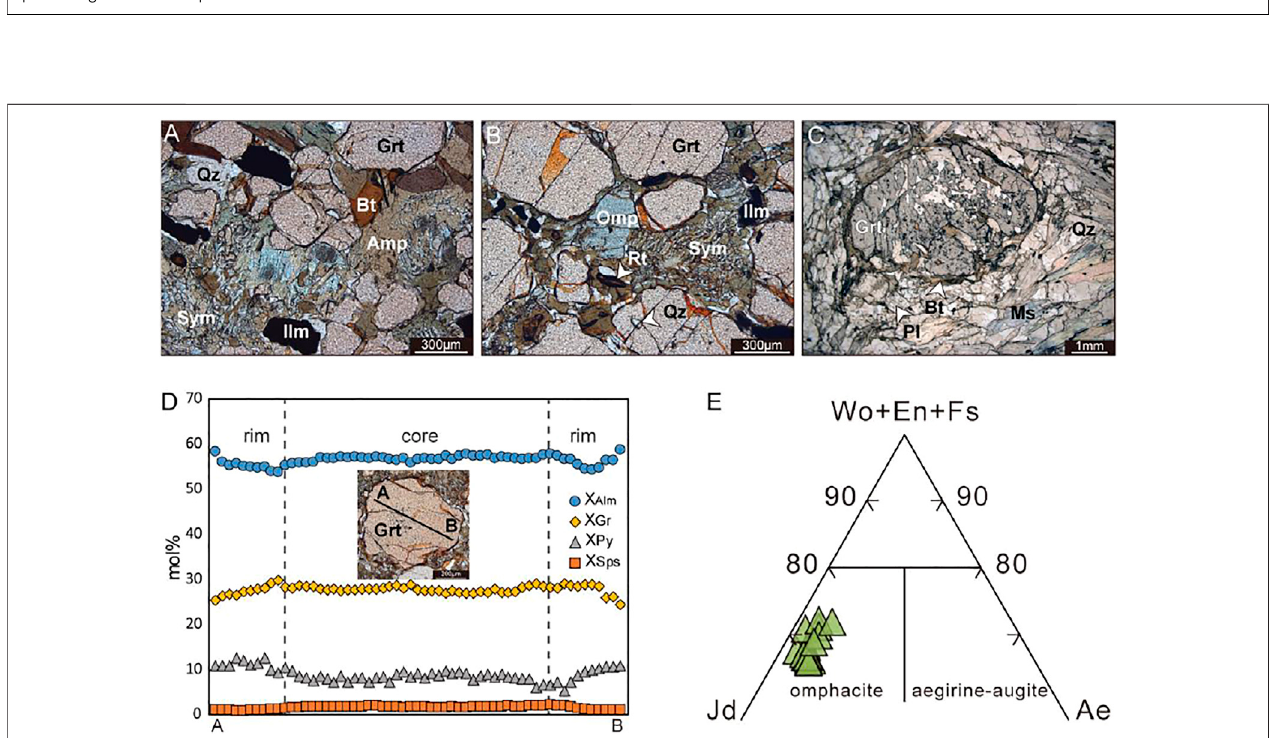
FIGURE3| Photomicrographsoftheeclogites16PK190 (A) and16PK194 (B) ,andgneiss16PK181 (C) . (D) Zoningpro fi leofagarnetintheeclogite16PK194. (E) Ternary diagram showing the composition of omphacite in eclogite. Mineral abbreviations are after Whitney and Evans (2010).